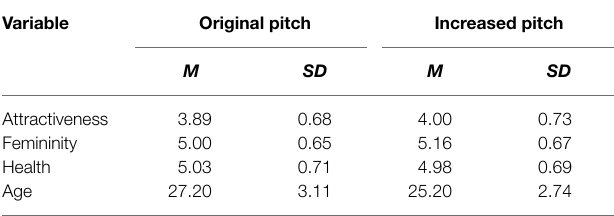
Ratings for attractiveness, femininity, and health were given on a 7-point scale. Age ratings were given via free input